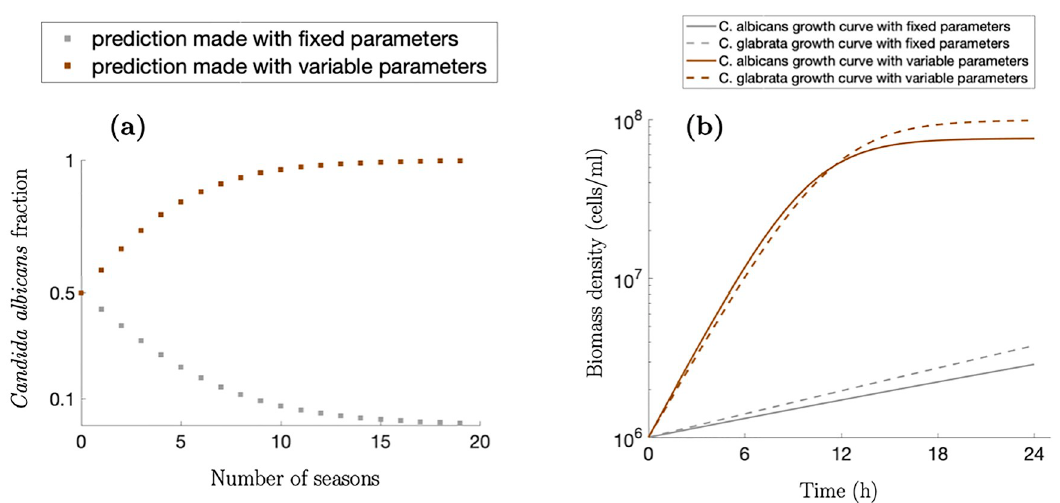
Fig 6. (a) Predicted multi-season competition outcomes . Modelled dynamics of the final C. albicans fraction in the microbial community consisting of C. albicans and C. glabrata in competition for a glucose at 0.1% glucose over 20 seasons of competition, as predicted by model (10). Each season’s length is 24 hours, the initial population density is 10 6 cells/ml, and the initial fraction of C. albicans in the community is 0.5. Brown markers show predictions based on the approach proposed in this study. Gray markers are predictions obtained by using growth parameters estimated at 1% of glucose for each species (see S1 Text, Appendix B, B7 Fig (c) for C. albicans and S1 Text, Appendix B, B5 Fig (b) for C. glabrata ). (b) Theoretical growth of C. albicans and C. glabrata on glucose . Theoretical growth dynamics for C. albicans (solid curves) and C. glabrata (dashed curves) in isolation, in 0.1% glucose over 24 hours. The simulation of the model (2) from the main text was carried out with variable growth parameters (brown curves) and growth parameters fixed at 1% glucose (gray